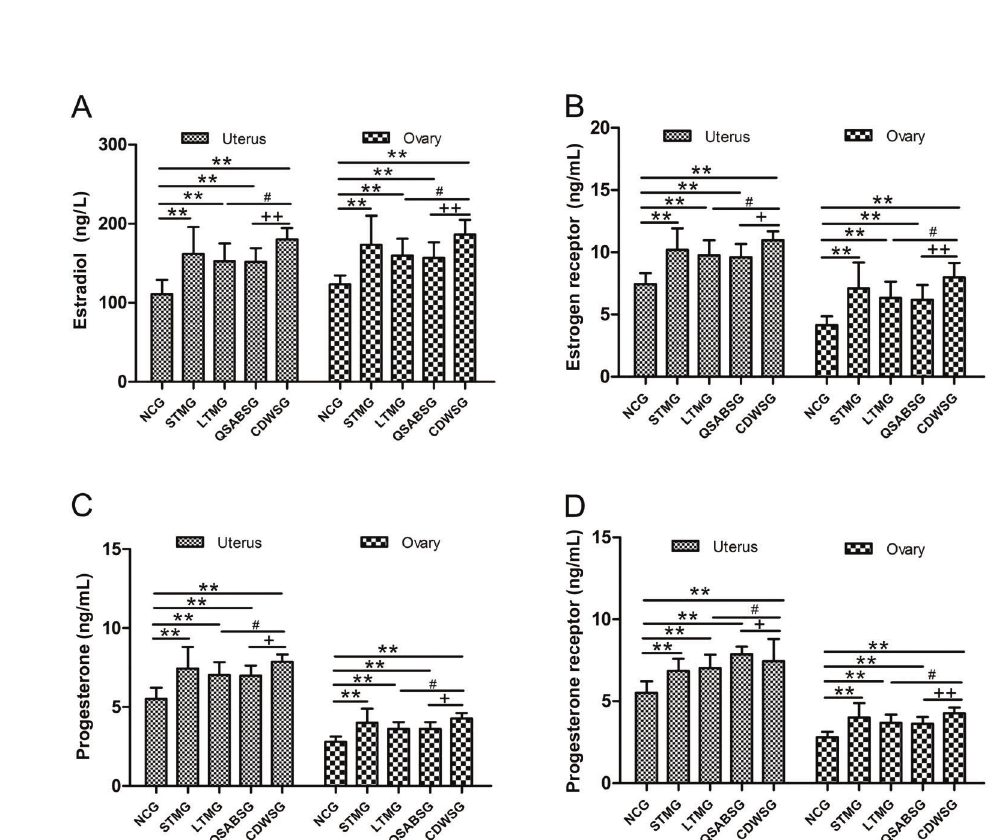
Figure 6. Effect on estradiol, progesterone, estrogen receptor, and progesterone receptor concentration in the uterus and ovary. Data are reported as means ± SD. **P o 0.01 compared with NCG; # P o 0.05 compared with LTMG; + P o 0.05, ++ P o 0.01 compared with QSABSG (ANOVA). NCG: normal control group; STMG: short-term model group; LTMG: long-term model group; QSABSG: Qi stagnation and blood stasis group; CDWSG: combining disease with syndrome